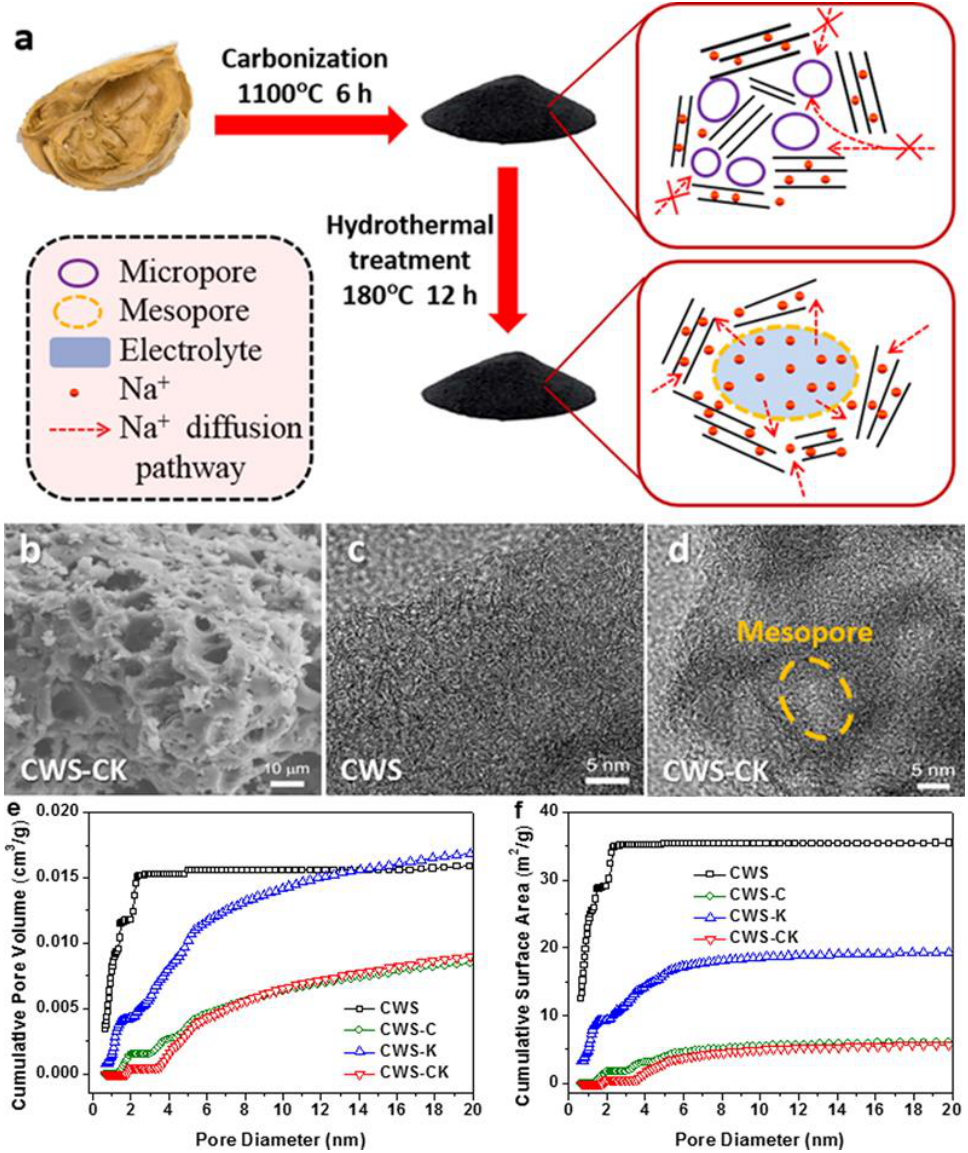
Figure 4. ( a ), Synthesis process of the hard carbon using walnut shell as a precursor. ( b ) SEM image of CWS-CK, ( c , d ) HRTEM images of CWS and CWS-CK, ( e , f ) specific pore volume and